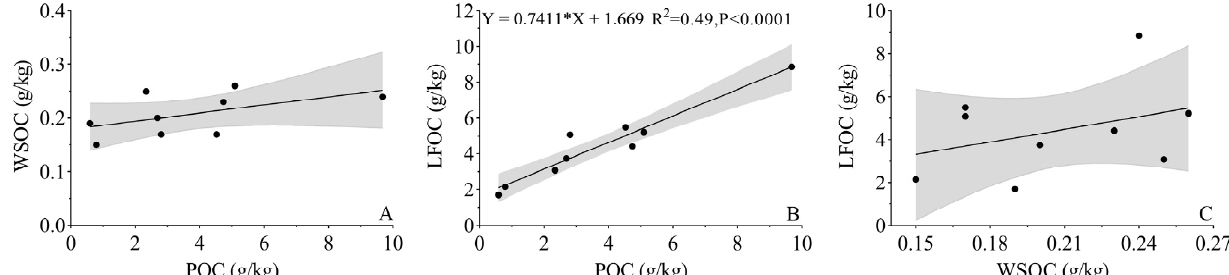
Figure 4. Relationships between labile organic carbon fractions in Quercus acutissima forest. Relationships between soil water-soluble organic carbon (WSOC) and particulate organic carbon (POC) ( A ); Relationships between light fraction organic carbon (LFOC) and particulate organic carbon (POC) ( B ); Relationships between light fraction organic carbon (LFOC) and soil water-soluble organic carbon (WSOC) ( C ).